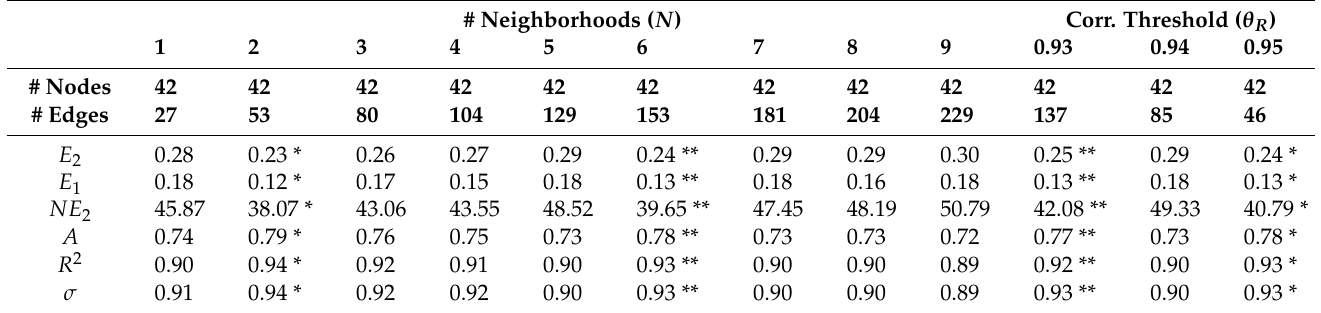
Table 7. Performance of the proposed model according to the edge density of meteorological networks. The edge density was adjusted using the number of neighborhood stations ( N ) and the threshold for the Pearson correlation coefficient between historical solar irradiance of stations ( θ R ). # Nodes and # Edges indicate the number of nodes and edges, respectively, in the meteorological networks constructed according to N and θ R . In addition, * and ** denote that the proposed model had the best and second-best performances with the corresponding N and θ R , respectively. The remaining hyper-parameters were set as L o = 12, L p = 1, and θ V = 0.00. # Neighborhoods ( N